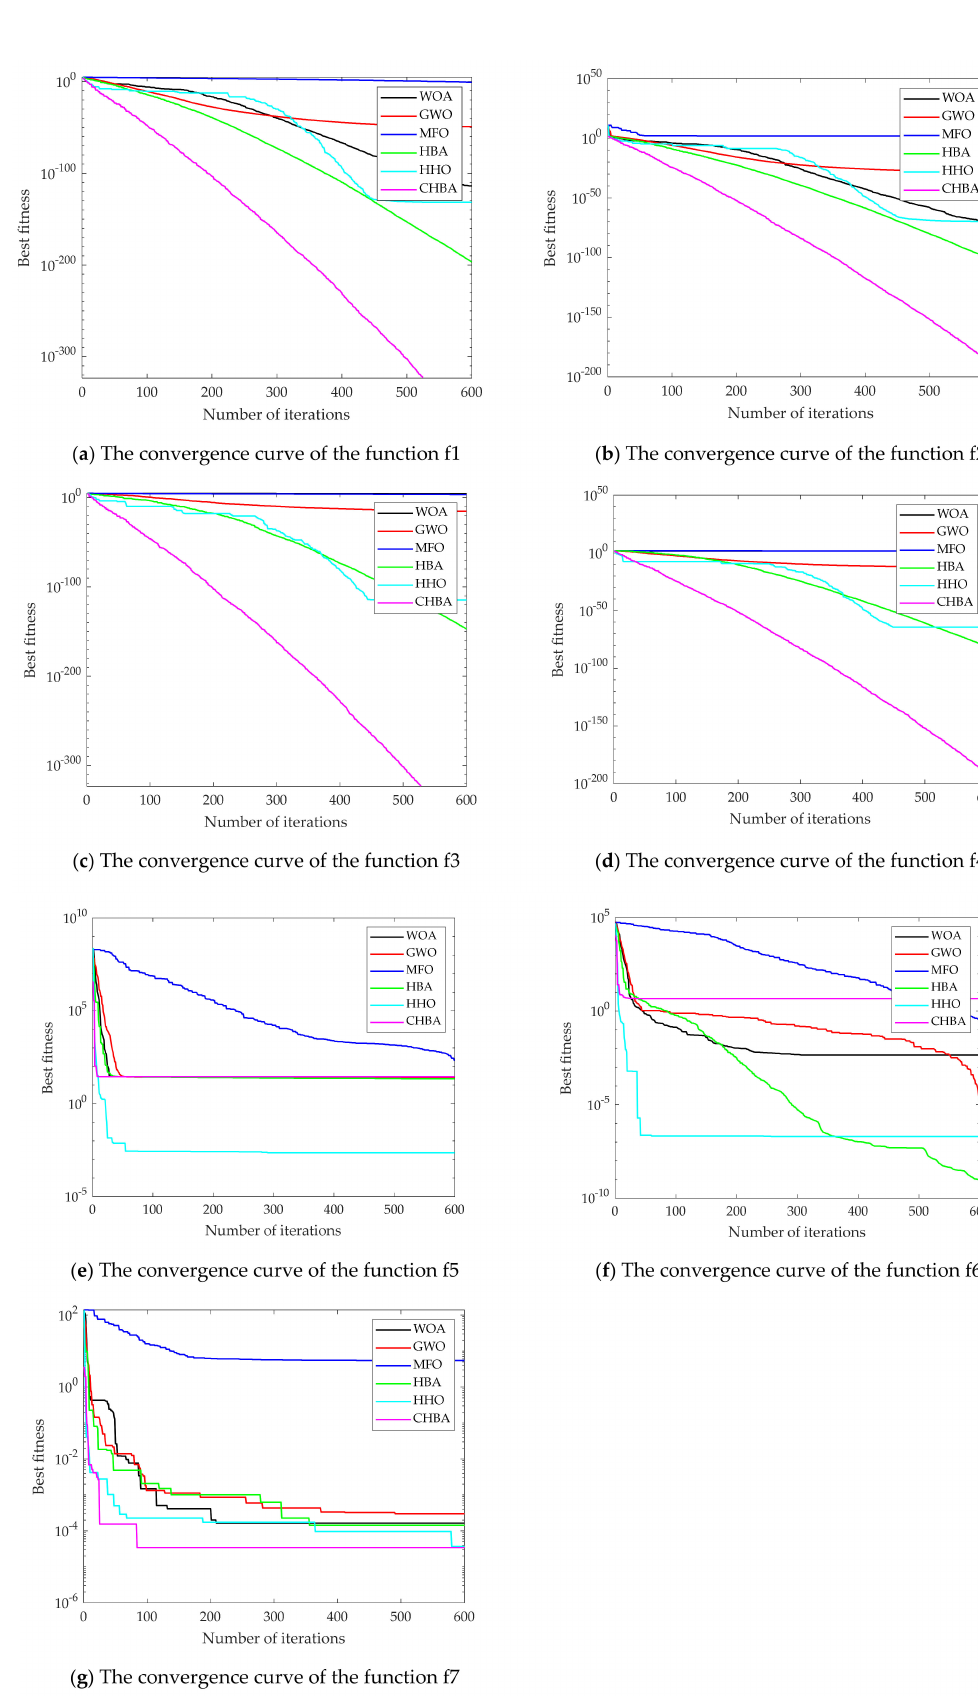
Figure 4. Convergence curve of high-dimensional single objective